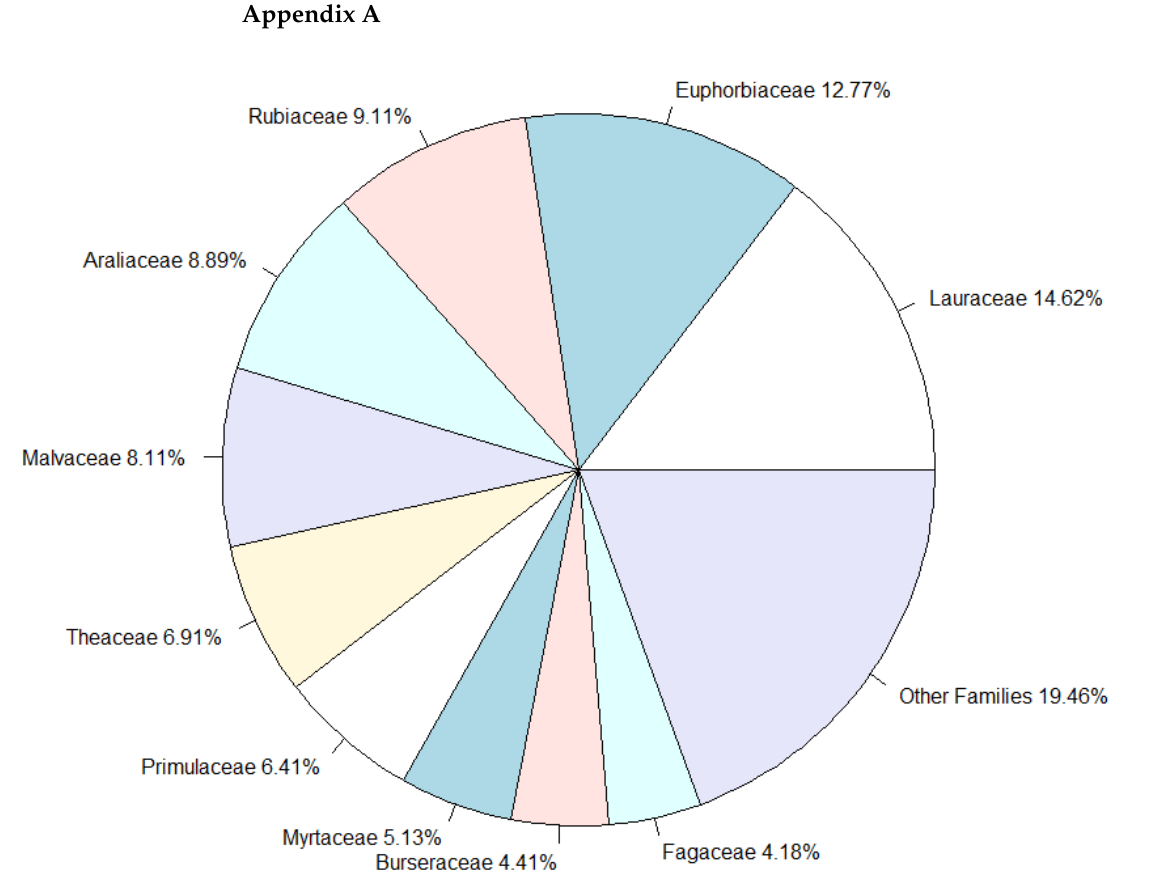
Figure A1. Proportion of different families in the study plot. Lauraceae was the largest family, while the Theaceae was the 6th and Fagaceae was the 10th largest family in the community. Target species Cryptocarya chinensis , Cr . concinna , Machilus breviflora , and M . chinensis are members of the Lauraceae family; Schima superba belongs to the Theaceae family; Castanopsis chinensis and Ca . fissa are members of the Fagaceae